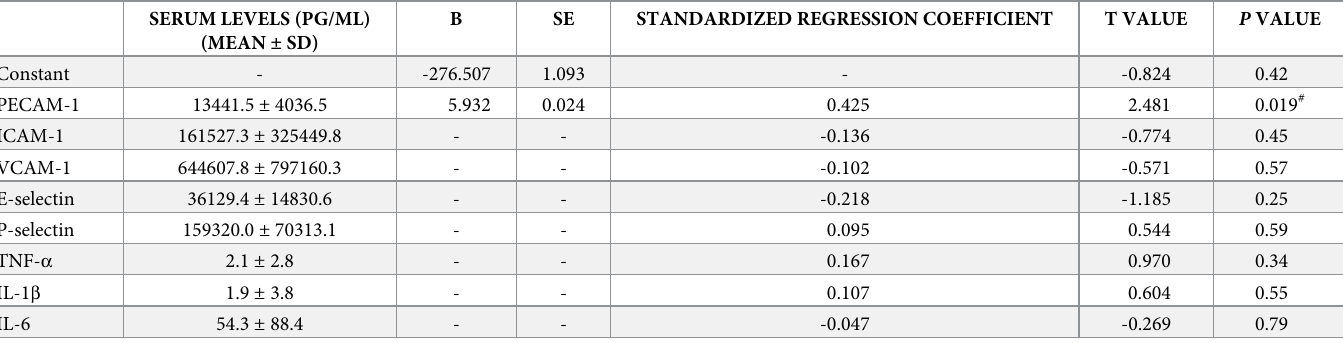
Table 3. Results of the stepwise multiple regression analysis performed to determine whether biomarkers correlate to pNF-H levels in patients with serum pNF-H. SERUM LEVELS (PG/ML) (MEAN ±